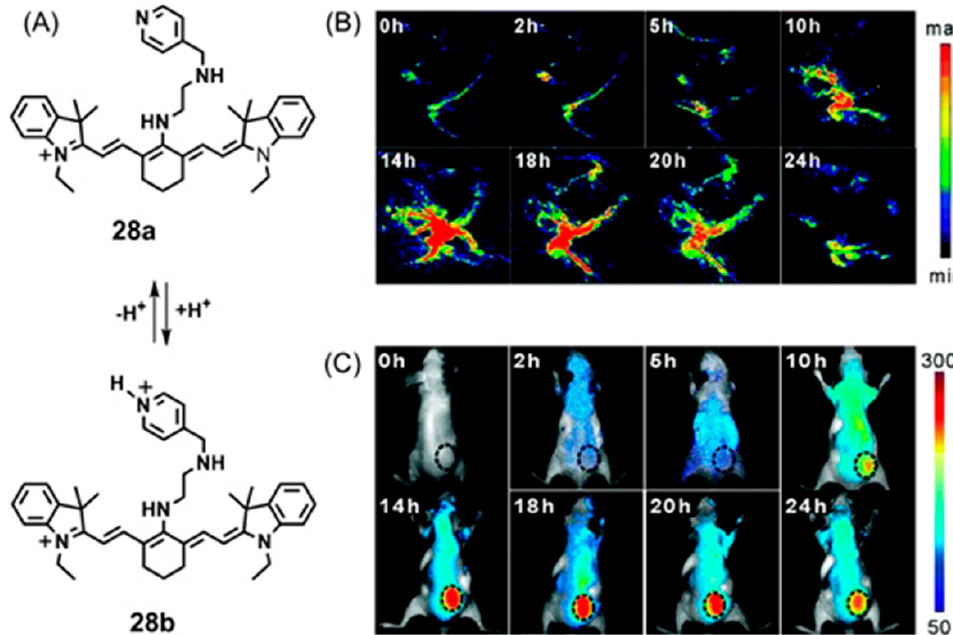
Figure 51. ( A ) Chemical structures of 28a and 28b . ( B ) Photoacoustic images of the tumor sites of MCF-7 tumor-bearing mice at different time points after intravenous injection of 28a . ( C ) near-IR fluorescence images of the tumor sites (represented by black dashed circles) of MCF-7 tumor-bearing living nude mice at different time points after intravenous injection of 28a . Adapted with permission of the Royal Society of Chemistry, from Tumor-targeted small molecule for dual-modal imaging-guided phototherapy upon near-infrared excitation. Meng, X.; Li, W.; Sun, Z.; Zhang, J.; Zhou, L.; Deng, G.; Gong, P.; Cai, L. 5, 47, 2017 ; permission conveyed through Copyright Clearance Center, Inc. [367].